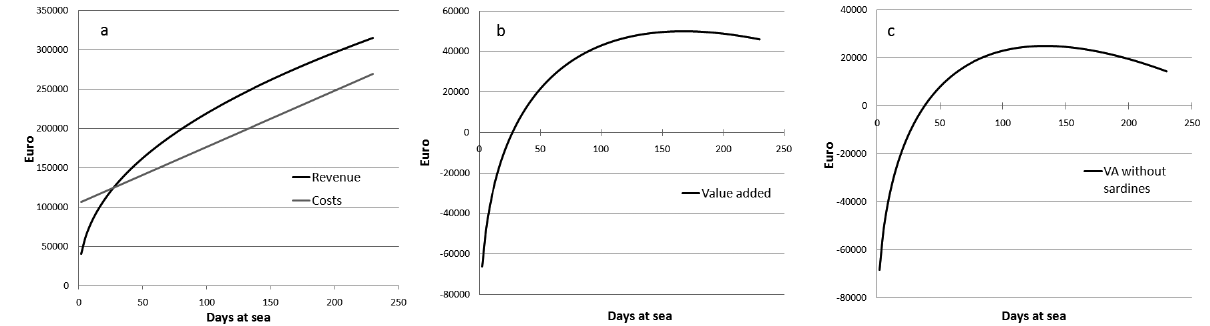
Fig . 2. – Economic results of an average vessel (with trawling technology) as a function of the number of days at sea: revenue and costs (a), value added (b), and value added if sardines are not landed